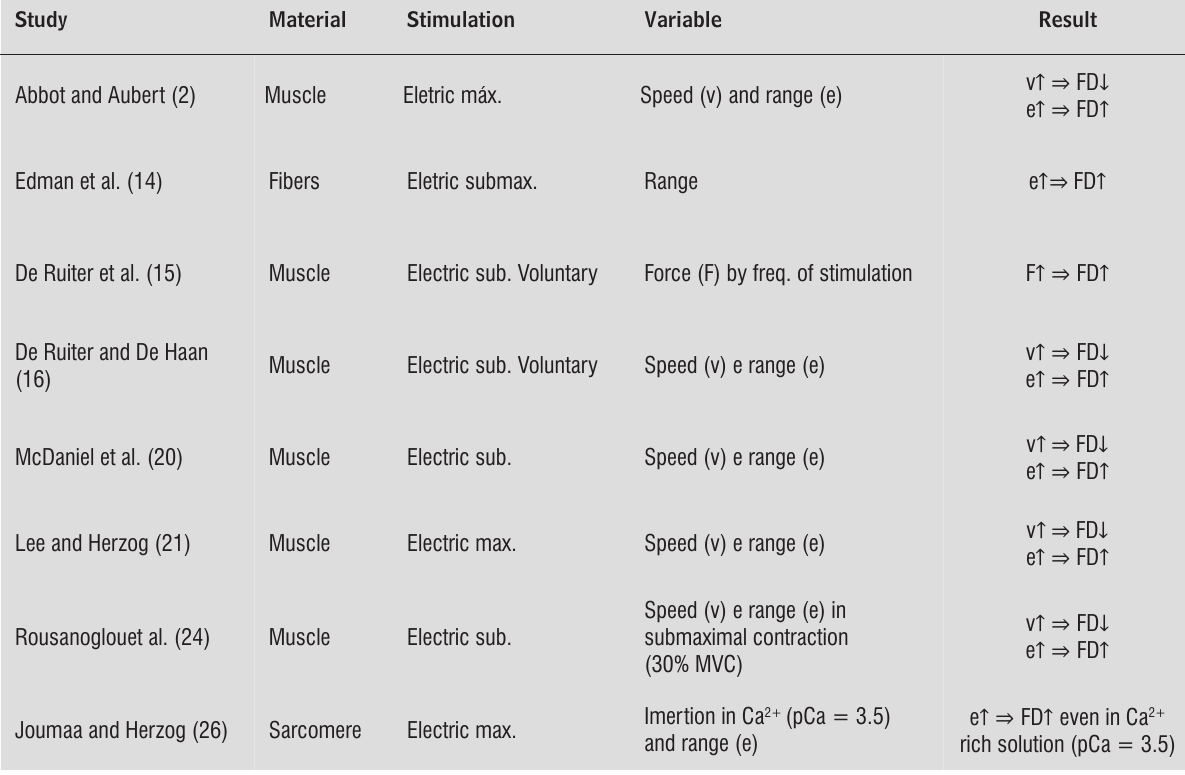
Table 1 - Main characteristics of the studies on FD as regard to type of stimulation, material used and the observed ef- fects considering the characteristics of the shortening applied Study Material Stimulation Variable